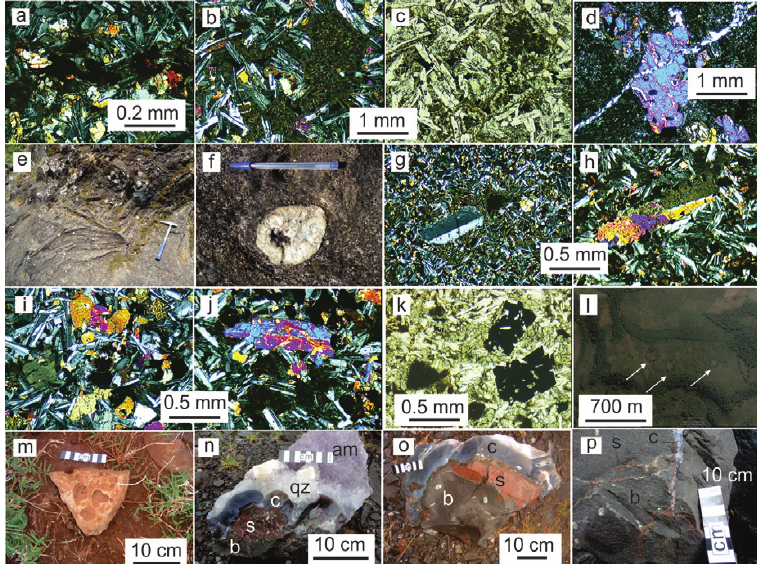
Figure 3 - Photomicrographs and field photos of the eight studied lava flows in the Entre Rios mining district. (a) : flow 1; (b) and (c) : flow 2; (d) , (e) and (f) : flow 3; (g) : flow 4; (h) : flow 5; (i) : flow 6 (j) : flow 7; (k) : microphenocrysts of magnetite in flow 8; (l) : satellite image of top of flow 8; arrows indicate gossans; (m) : silicified basalt on top of flow 8; (n) , (o) : silicified sandstone in geodes of flow 5, showing a sequence of chalcedony, fine quartz, coarse quartz and amethyst; (p) : sand dikes in flow 5 evolving to chalcedony along fracture. Symbols: b = basalt, c – chalcedony, s = silicified sandstone, q = quartz, am =